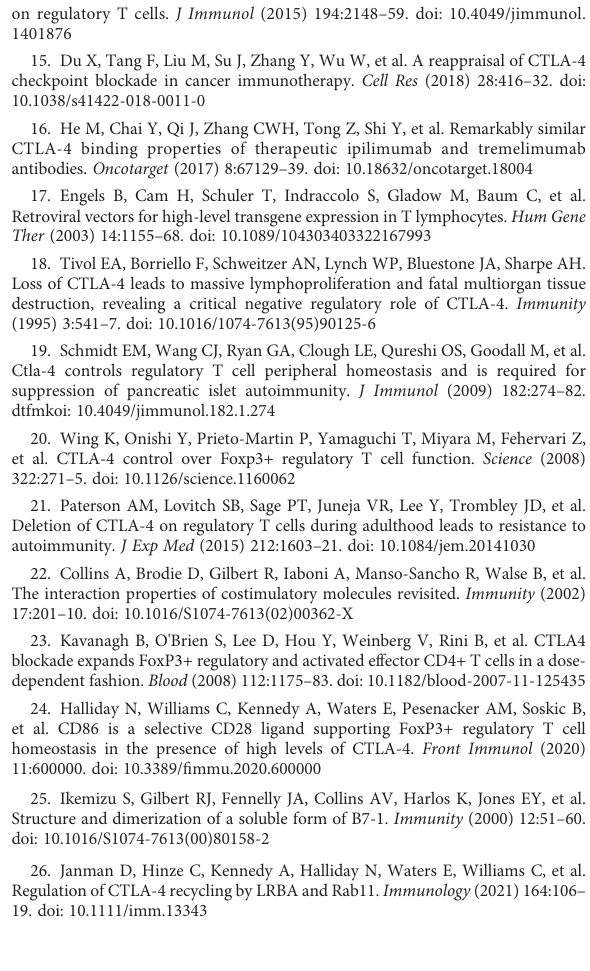
Gating strategy for transendocytosis assays. Mixtures of Jurkat cells and CTV-labelled DG75 B cells expressing GFP ligands were gated by scatter and then on singlet cells. Cells were then gated for analysis into CTV+ (ligand donor cells) and CTV-ve (CTLA-4 + cells) to determine GFP ligand loss from the CTV+ donors and GFP gain by CTLA-4 + Jurkat recipient